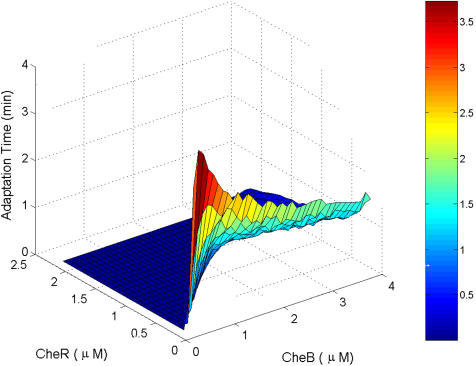
Modeling chemotaxis